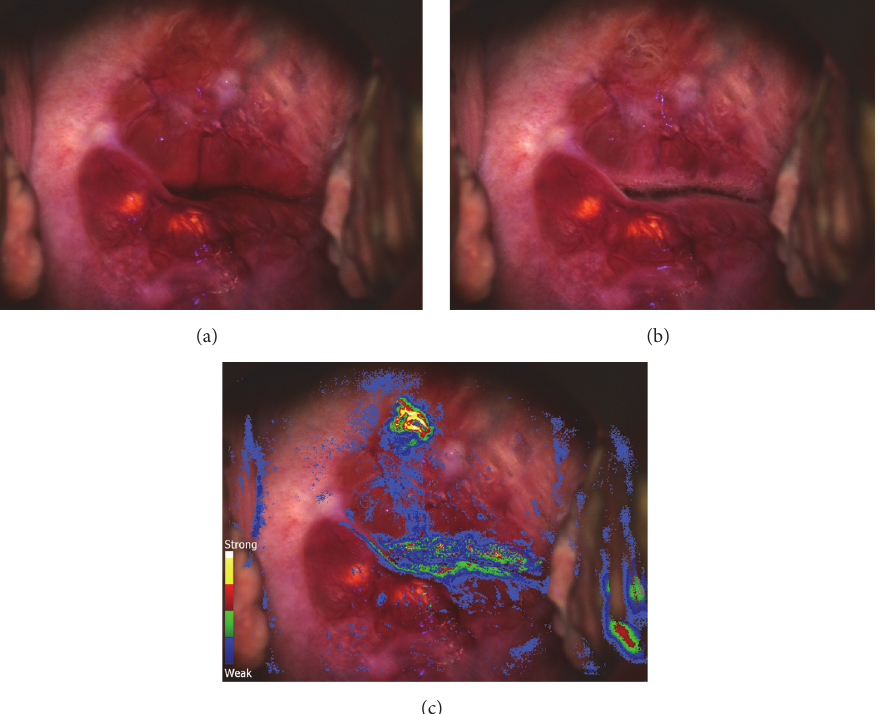
Figure 1: (a) The cervix prior to the application of acetic acid; (b) the cervix 30 seconds after acetic acid was applied. (c) The DSI color-coded map, overlaid on the cervix. The upper part of the DSI color scale (red, yellow, and white) indicates persistent/intense acetowhitening. The 11-12 o’clock area highlighted by the map was biopsied and invasive squamous carcinoma was